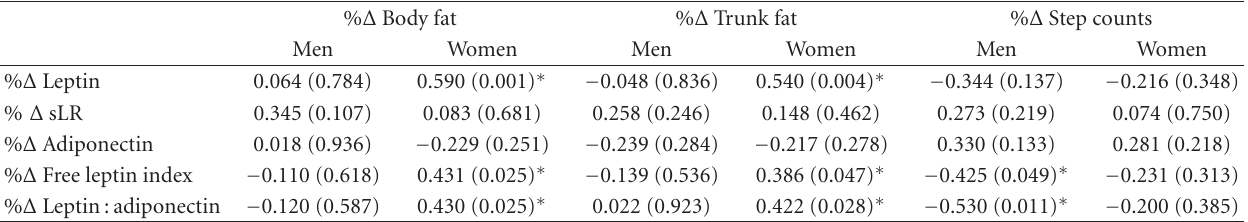
Table 6: Spearman correlations by gender for percent change from baseline to 6 months in adipokines and body fat and step